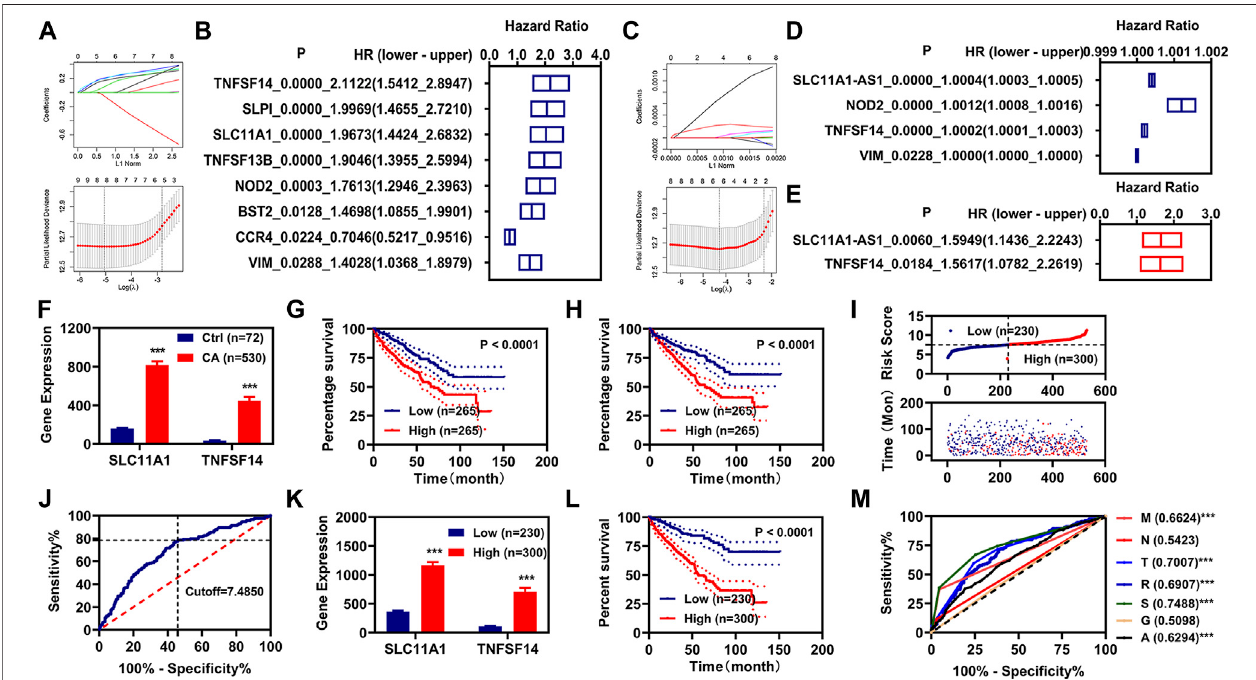
FIGURE 2 | Construction of risk assessment model. (A,B) , K-M analysis and LASSO analysis illustrated 8 IR-DEGs. (C,D) , Univariate Cox regression analysis and LASSO analysis illustrated 5 IR-DEGs. (E) , Multivariate Cox regression illustrated two IR-DEGs (SLC11A1 and TNFSF14). (F) , The expression of these two IR-DEGs (SLC11A1 and TNFSF14) inthenormal and KIRCcancerpatients. (G,H) ,K-Mcurveofthese twoIR-DEGs (SLC11A1and TNFSF14). (I) ,Riskscoresand survivalstatus foreachKIRC. (J) ,Cutoffvaluefortheriskmodel. (K) ,TheexpressionofthesetwoIR-DEGs(SLC11A1andTNFSF14)indifferentriskgroups. (L) ,K-Mcurveofthe risk model. (M) , ROC curve of different clinical characteristic and the risk model. * p < 0.05, ** p < 0.01, *** p <